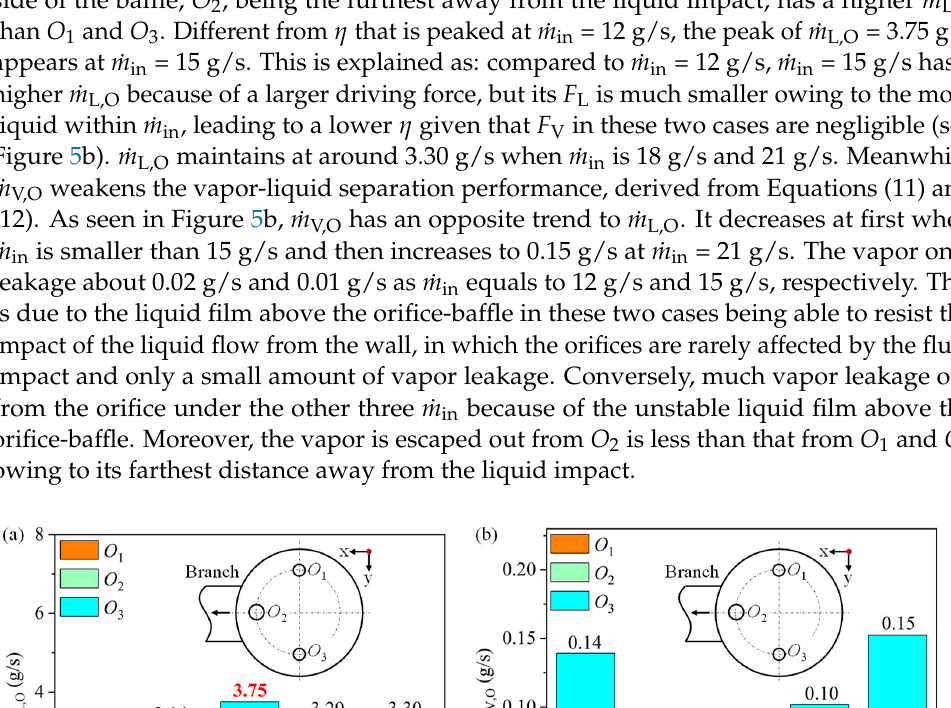
Figure 6. ( a ) Instructions and distributions of velocity and density in each orifice at ( b ) 9 g/s, ( c ) 12 g/s, ( d ) 15 g/s, ( e ) 18 g/s and ( f ) 21 g/s.